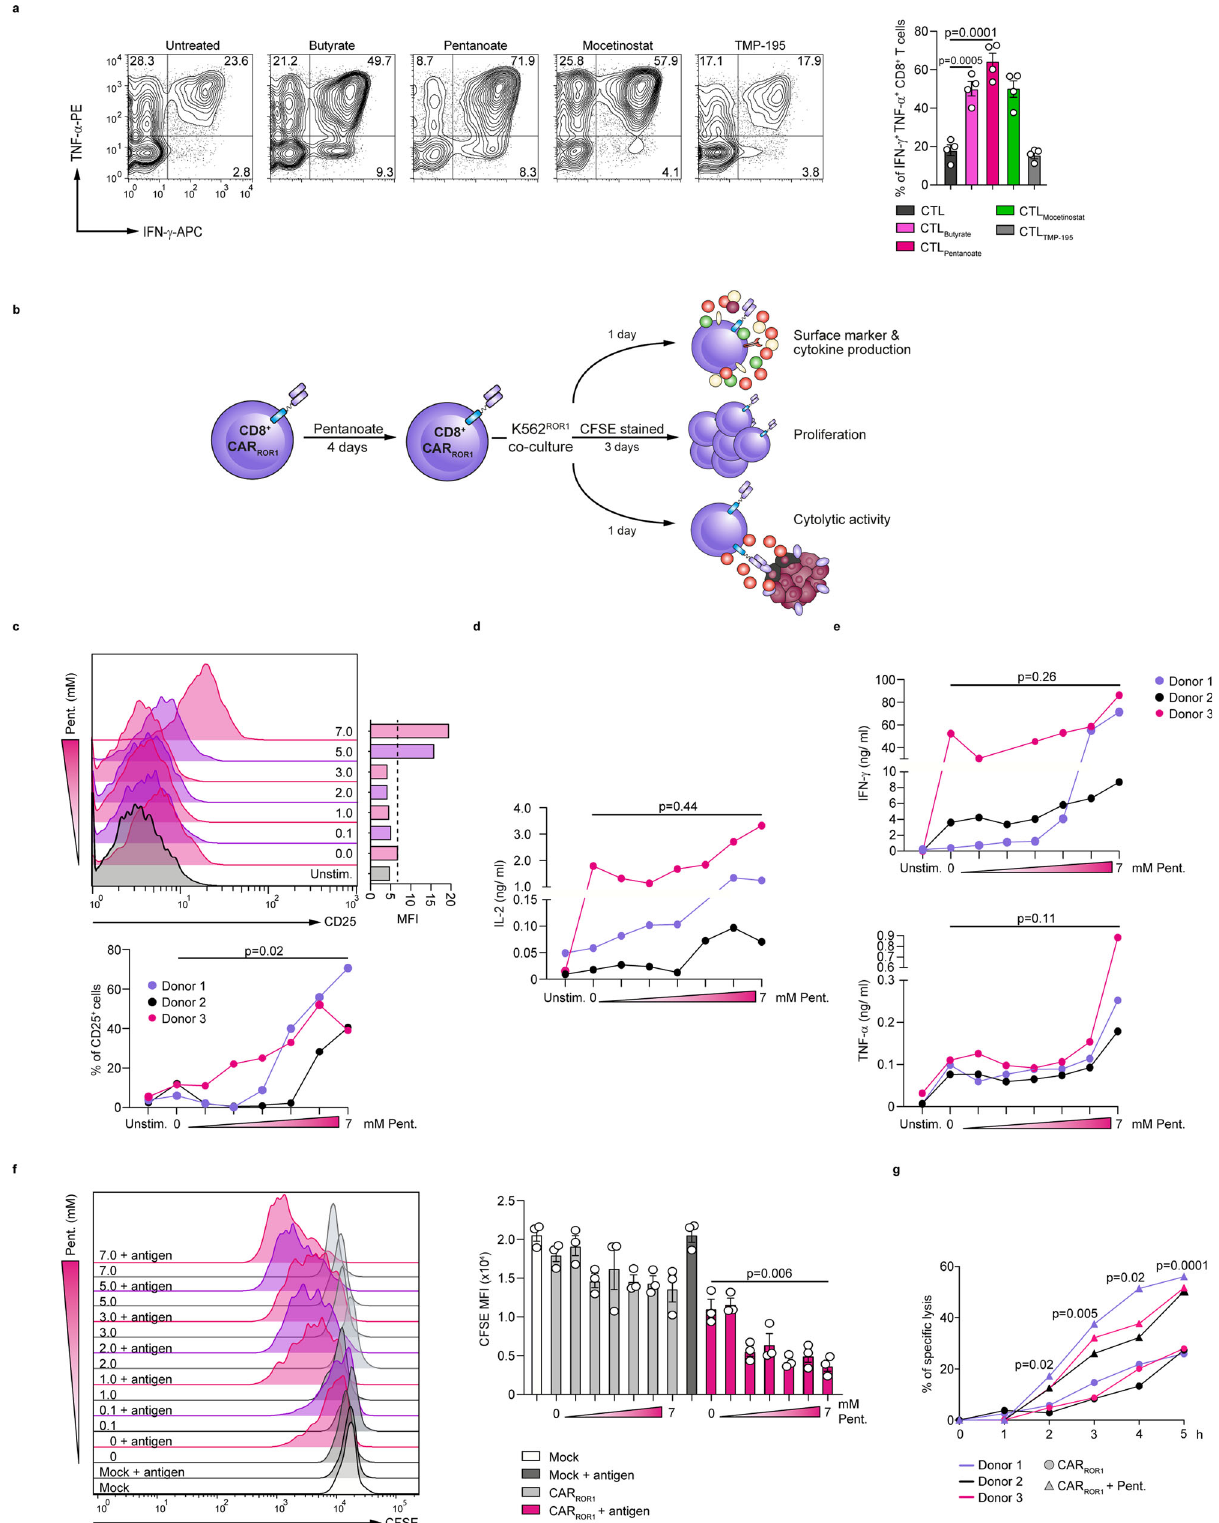
protein S6, the pan-HDAC inhibitor TSA was shown to increase mTOR activity in T cells 13 , suggesting a certain level of inter- dependence between HDAC inhibition and metabolic effects. In the future, the complex cross-talk between SCFA-mediated epigenetic changes and their multiple effects on the cellular metabolism of CTLs should be investigated in more